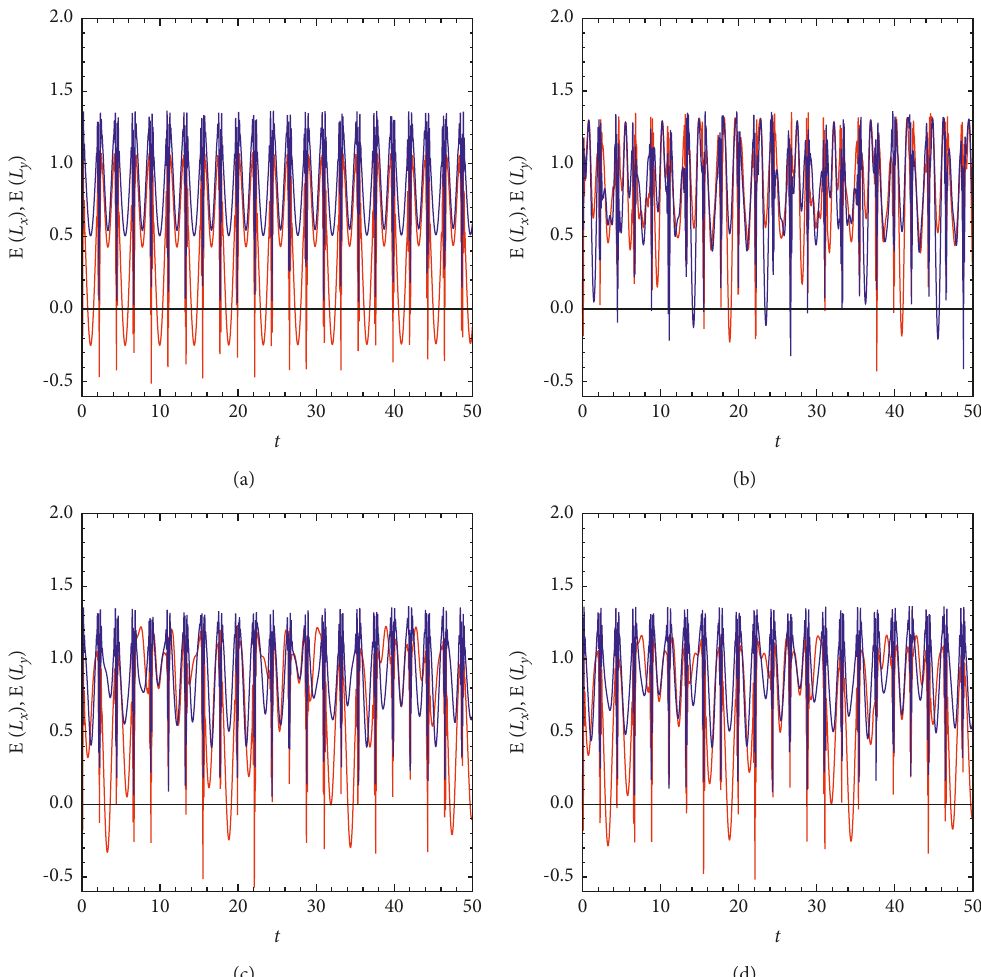
Figure 5: The components E